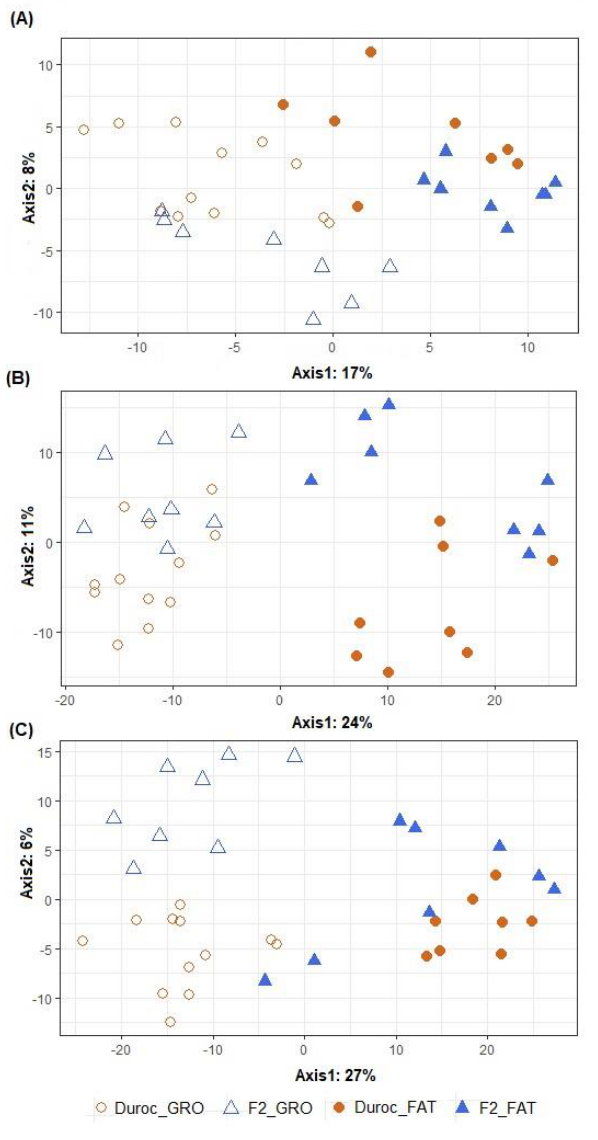
Figure 3. Graphical representation of partial least squares-discriminant analysis (PLS–DA) on microbial OTUs in ileum ( A ), cecum ( B ) and distal colon ( C ). Obtained in pigs differing in their producing type (PT): Duroc vs. F2 (Pietrain × F1: Duroc × Landrace) and production phase (PP): growing (GRO: 28.5 kg) vs. fattening (FAT: 88.1 kg). Each point represents a different sample and a greater distance between two points infers a higher dissimilarity between them. Statistical comparisons were made between PP ( p < 0.001 for all intestinal segments), between PT ( p = 0.044, 0.032 and 0.171 for ileum, cecum and distal colon, respectively) and to test PP by PT interaction ( p = 0.667, 0.542 and 0.232 for ileum, cecum and distal colon, respectively).